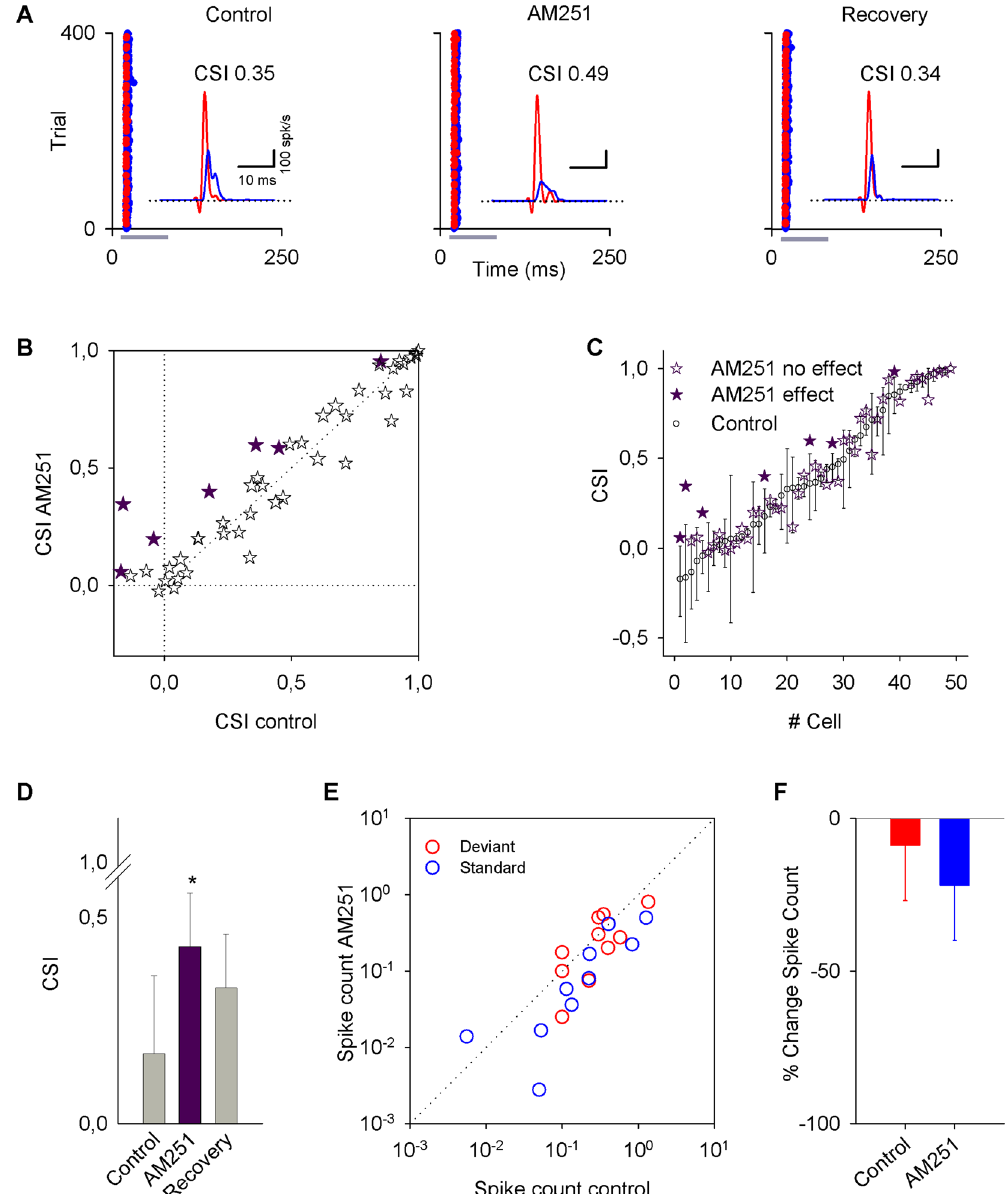
Figure 4. Effects of AM251 on the activity of IC neurons. ( A ) Typical recordings of an IC neuron under an oddball stimulation paradigm before (control), during (AM251), and after (recovery) an i.v. application of AM251. (For this neuron, the standard frequency was 8574 Hz, and the deviant frequency was 10472 Hz.) The insets show the PSTH of the responses. ( B ) Scatter plot of the CSI in control condition versus AM251 application. ( C ) Bootstrapping analysis showing that AM251 produced significant changes in the CSI only in 7/49 neurons. ( D ) Bars represent the average of the CSI values ± SE in control condition, AM251 application and recovery. ( E ) Scatter plot of the firing rate showing the spike count for deviant and standard frequencies in control condition versus AM251 application. ( F ) Bars show the percent change in the spike count averaged for deviant and standard stimuli by AM251 application. There is a tendency for a decrease in the firing rate for both frequencies. Vertical bars represent the % change ±